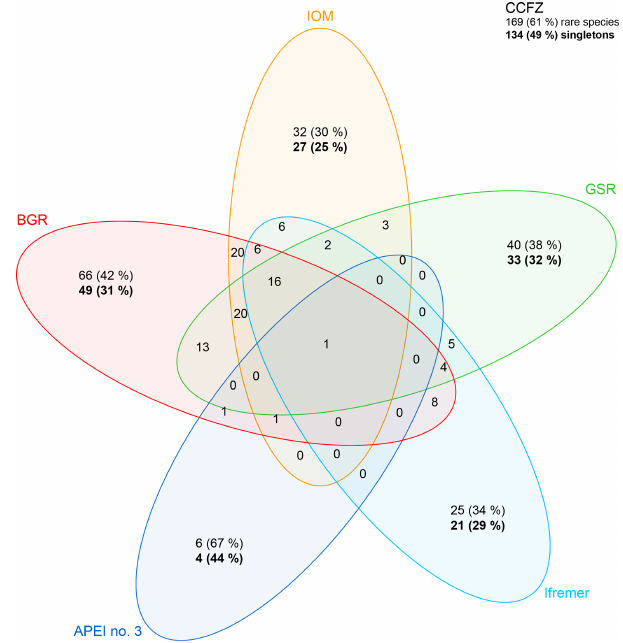
Figure 9. Venn diagram with the records of rare (being recorded in only one area, with corresponding percentage) and common species among sampled areas and for the eastern CCFZ. Bold values indi- cate the number of species with a single specimen (singletons, with corresponding